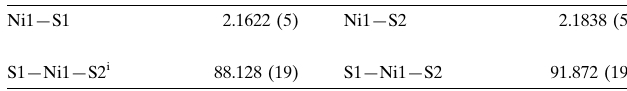
Selected geometric parameters (A˚ , (cid:1) ).